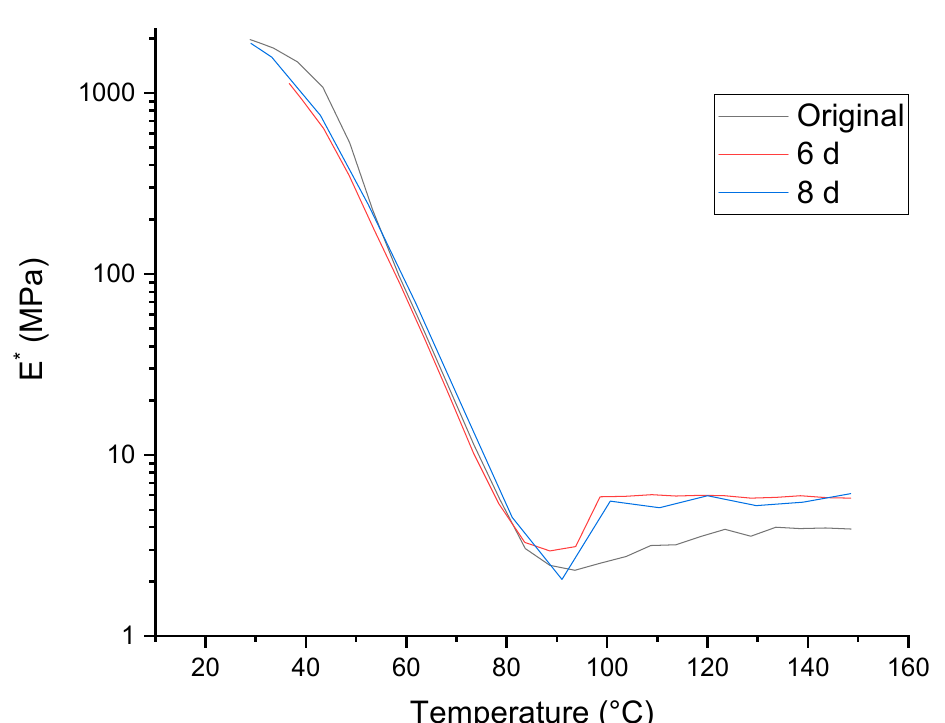
Figure 3. Dependency of the complex modulus of elasticity on temperature at di ff erent aging times.